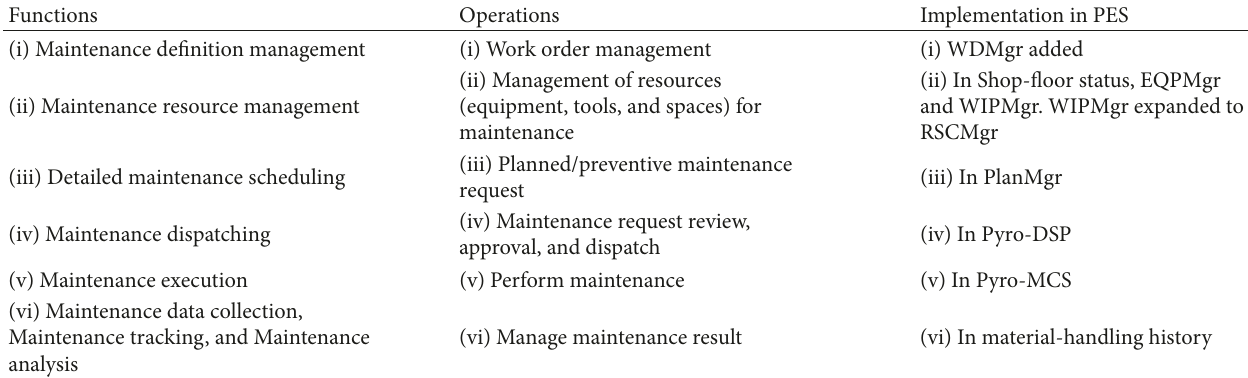
Table 2: Implementation of maintenance operations management functions in